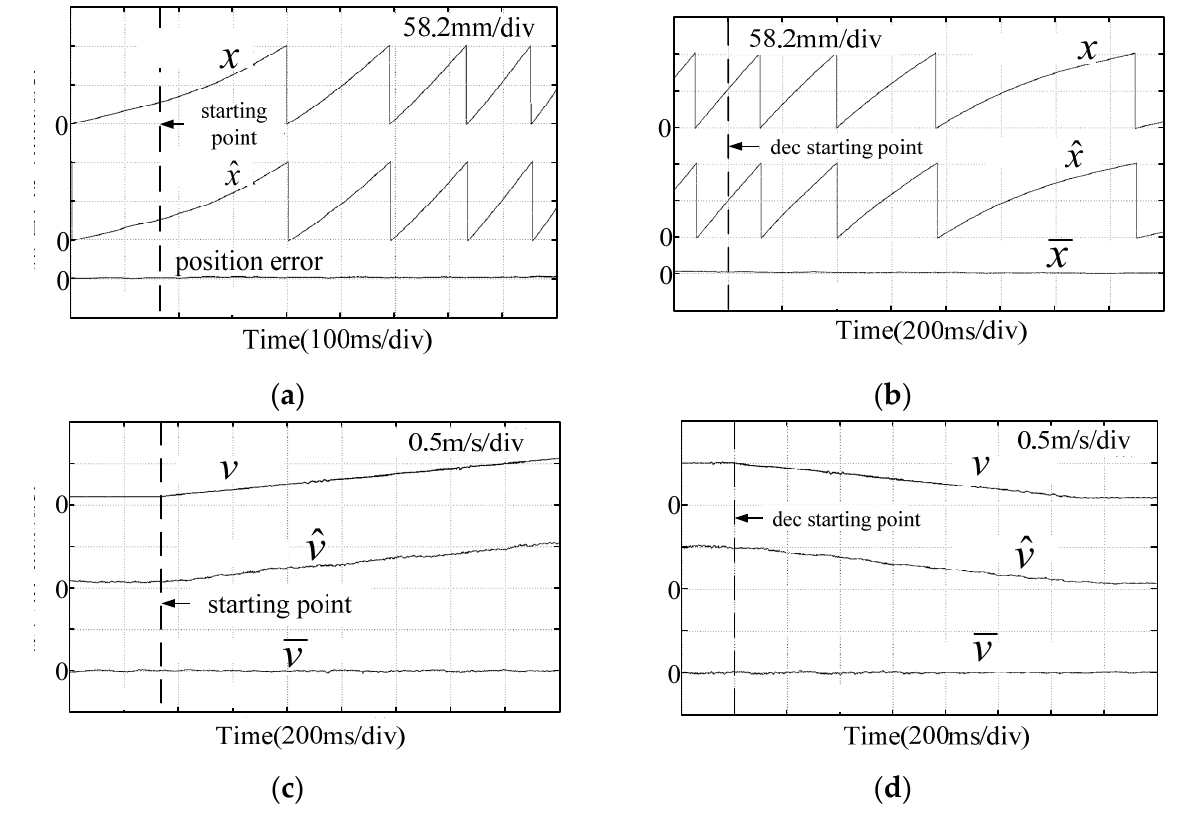
Figure 14. The position and speed in the acceleration and deceleration. ( a ) Position at acc-time; ( b ) position at dec-time; ( c ) speed at acc-time; ( d ) speed at dec-time. Finally, the sensorless experiment under the load was carried out. The load was applied by the pulley, as shown in Figure 15, and the load thrust was 30 N. When the WS-PMLM starts, the heavy object falls on the ground due to the long string. It has no load at this time. After the motor runs, the rope is tightened and the heavy object is lifted. This is the moment of sudden load. The phase current was monitored to characterize the change before and after loading. The speed command was 0.582 m/s. The experimental waveform is shown in Figure 16.